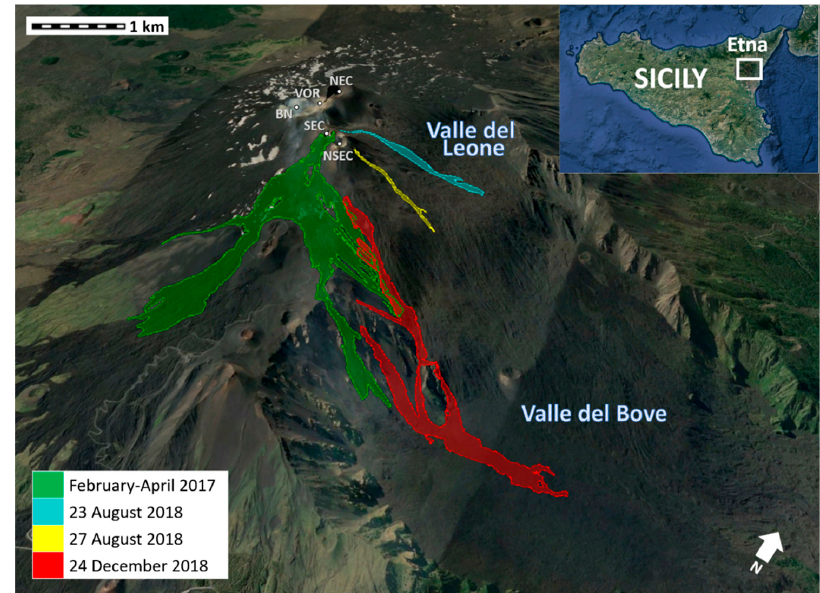
Figure 1. Google Earth 3D view (from the South-East) of Etna’s lava flows extracted from PlanetScope images used to test our classifier: February–April 2017 (green), 23 and 27 August 2018 (turquoise and yellow, respectively), and 24 December 2018 (red). “Valle del Leone” is the northeastern part of “Valle del Bove”, a large horseshoe-shaped depression located on the eastern side of the volcano. The active summit craters are also indicated: North-East Crater (NEC), Voragine (VOR), Bocca Nuova (BN), South-East Crater (SEC), and New South-East Crater (NSEC).